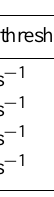
Table 4. Discharge thresholds corresponding to the levels of vigi-